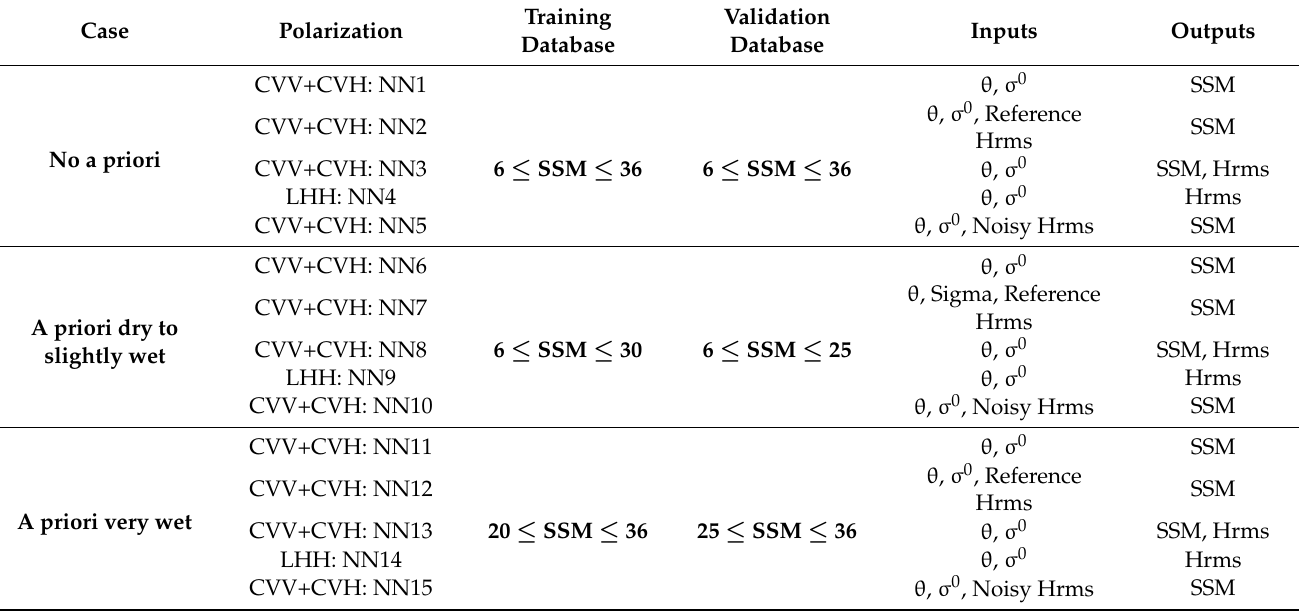
Table 3. Input and output parameters for the fifteen neural networks tested in this study. Reference Hrms refers to the Hrms values used in the IEM model while the noisy Hrms refers to the reference Hrms values with an added